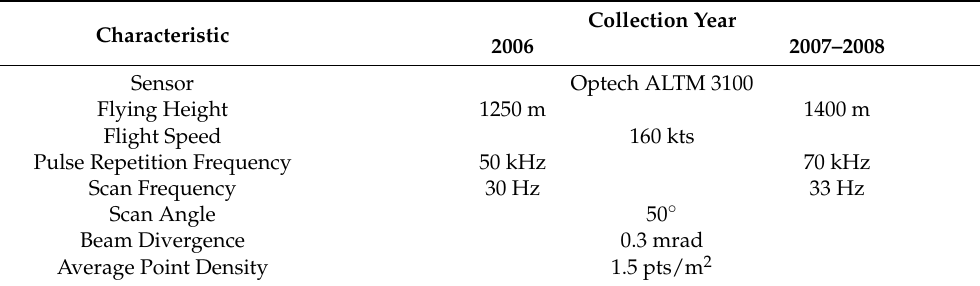
Table 2. Airborne Laser Scanning (ALS) acquisition